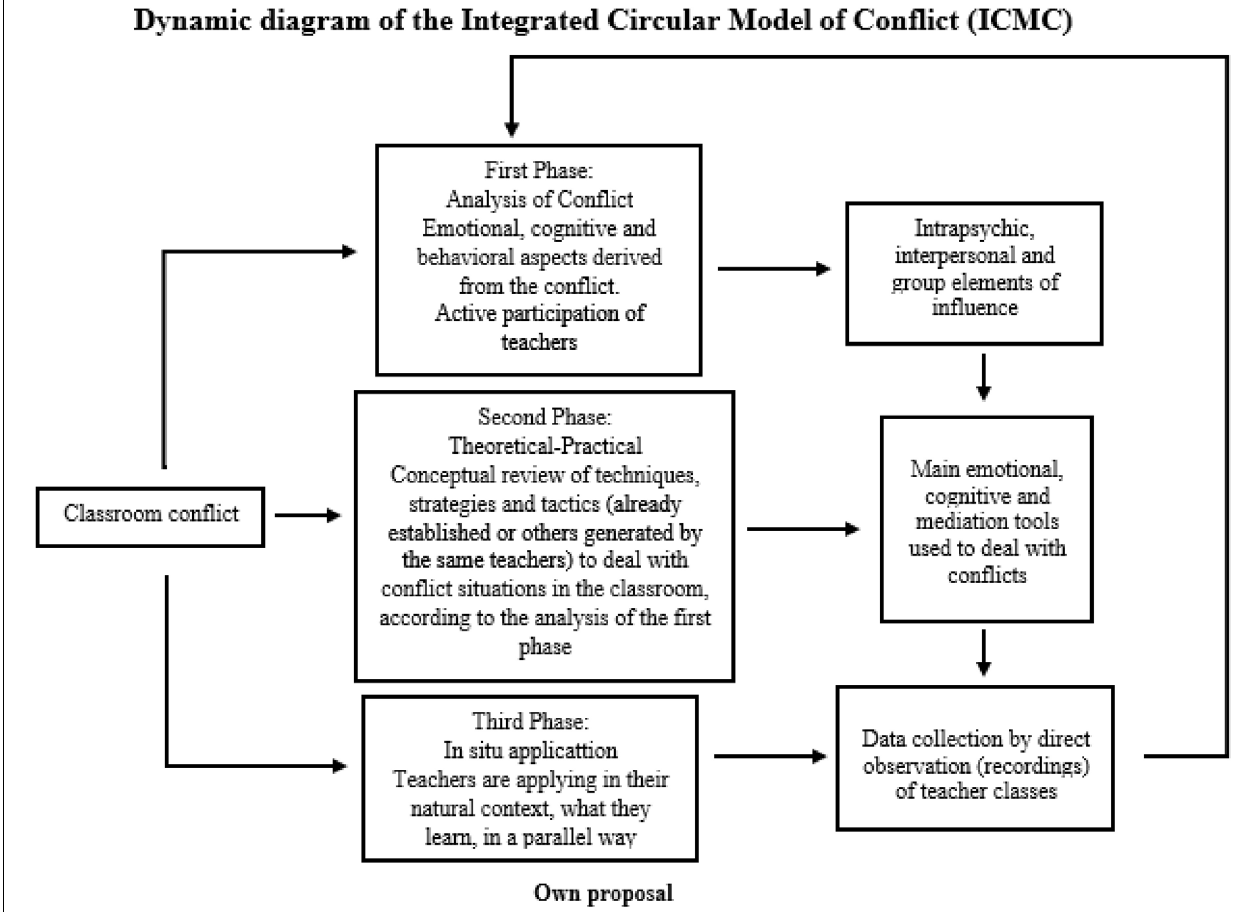
DIAGRAM 1 | Dynamic diagram of the Integrated Circular Model of Conflict